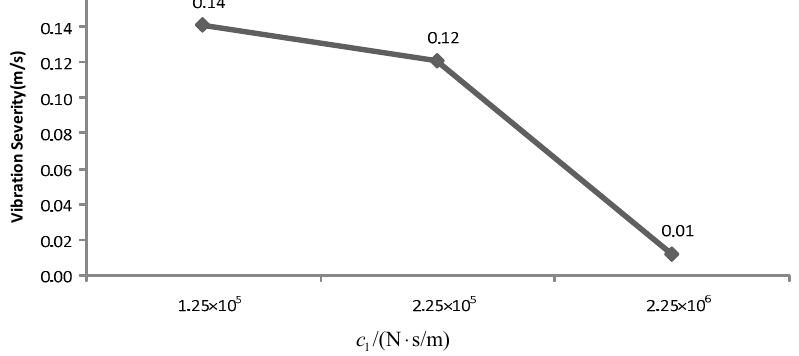
Figure 5. E ff ect of di ff erent equivalent damping on vibration severity of hydraulic Figure 5. Effect of different equivalent damping on vibration severity of hydraulic cylinder.